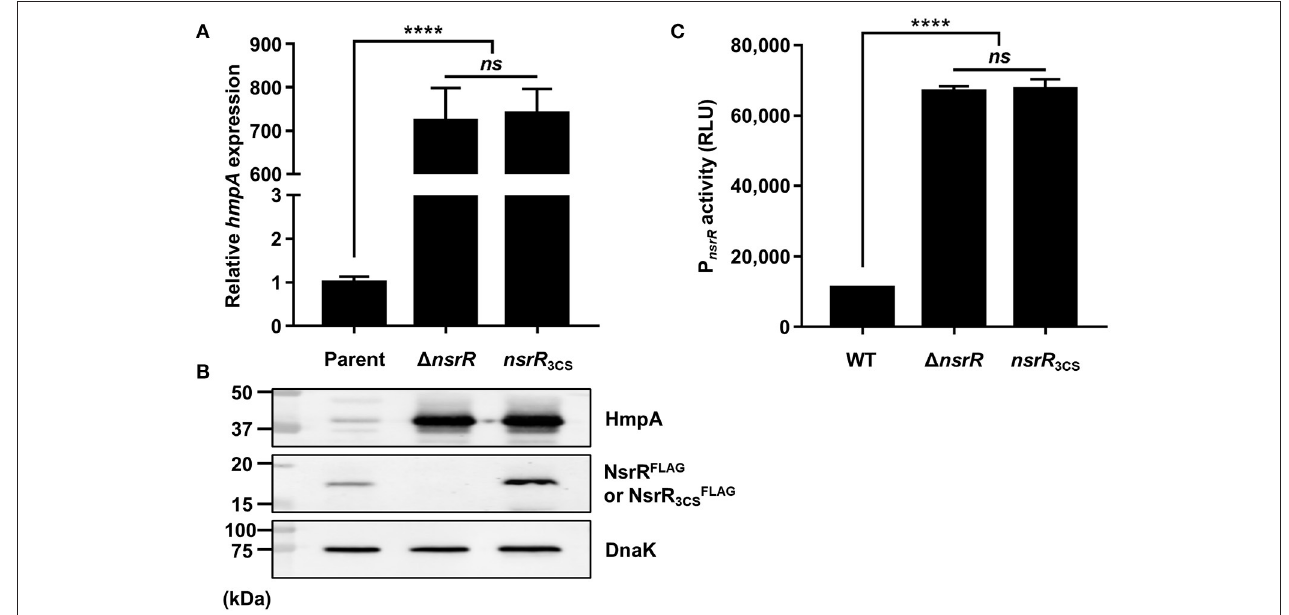
FIGURE 3 | The role of the three cysteine residues in NsrR on hmpA and nsrR transcription. (A,B) Total RNA and proteins were isolated from the parent and mutant strains grown aerobically to an A 600 of 0.5. (A) The hmpA transcript levels were determined by qRT-PCR, and the hmpA transcript level in the parent strain was set to 1. (B) The cellular HmpA, NsrR FLAG or NsrR FLAG 3CS , and DnaK (internal control) protein levels were determined by Western blot analysis. Molecular size markers (Bio-Rad) are shown in kDa. Parent, parent strain; 1 nsrR , nsrR- deletion mutant; nsrR 3CS , strain expressing apo-locked NsrR FLAG . (C) A PCR fragment carrying the P nsrR was cloned into pBBR-lux to create a reporter plasmid, pGR2025. The wild-type and mutant strains containing pGR2025 were grown aerobically to an A 600 of 0.5, and then used to measure the cellular luminescence. Error bars represent the SD. Statistical significance was determined by the Student’s t -test ( **** p < 0.00005; ns , not significant). RLU, relative luminescence unit; WT, wild type; 1 nsrR , nsrR -deletion mutant; nsrR 3CS , strain expressing apo-locked NsrR.